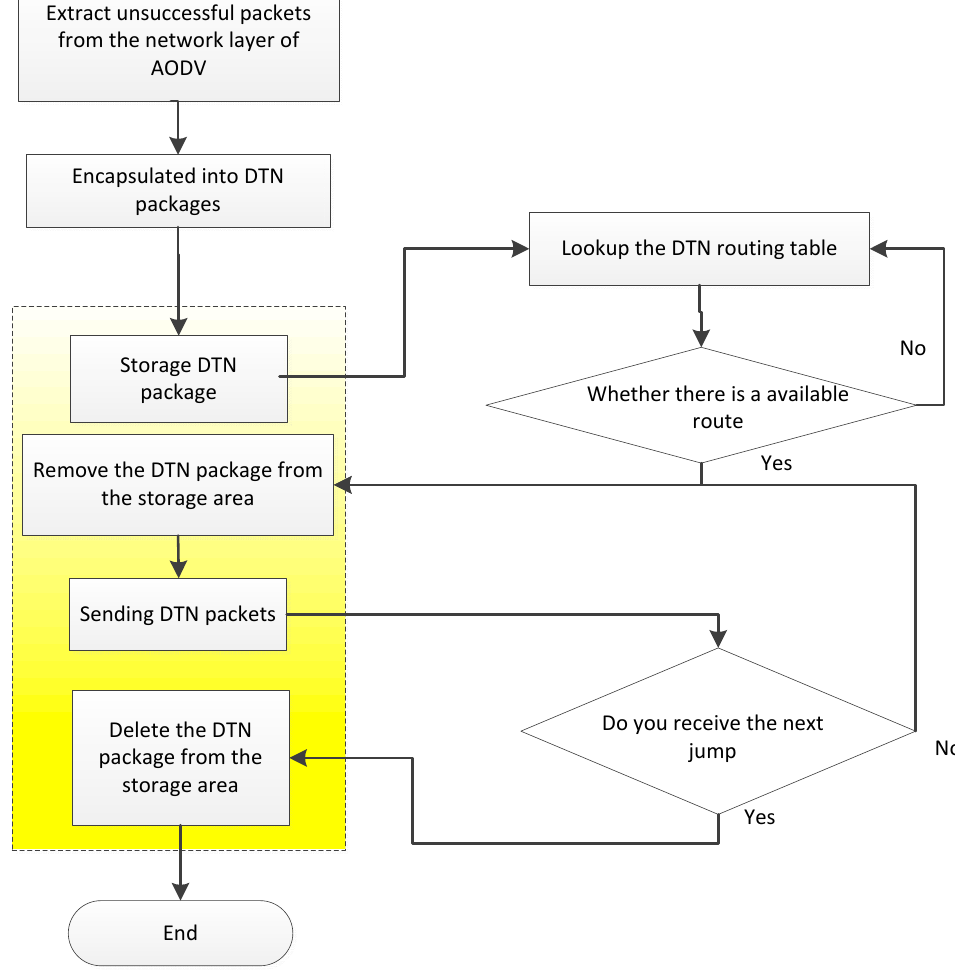
Figure 8. Sending of the DTN package process.